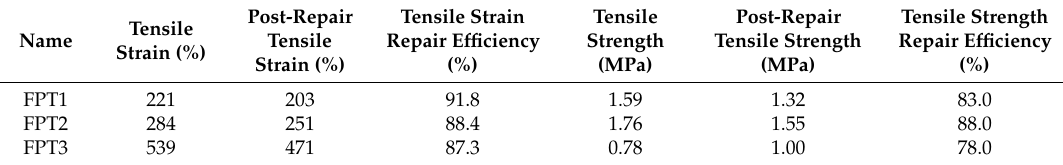
Table 1. The tensile test of FPT1, FPT2, and FPT3 before and after self-repairing.